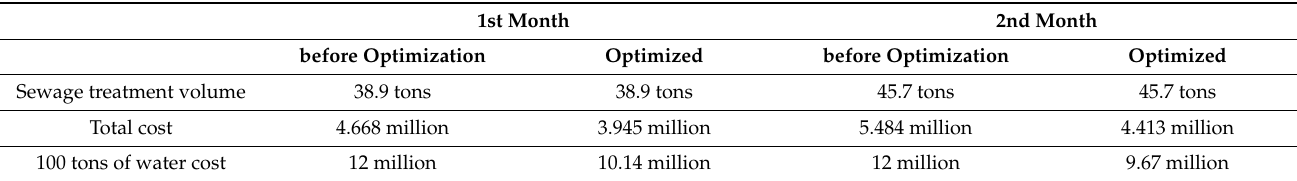
Table 1. Sewage treatment cost of factory A for two